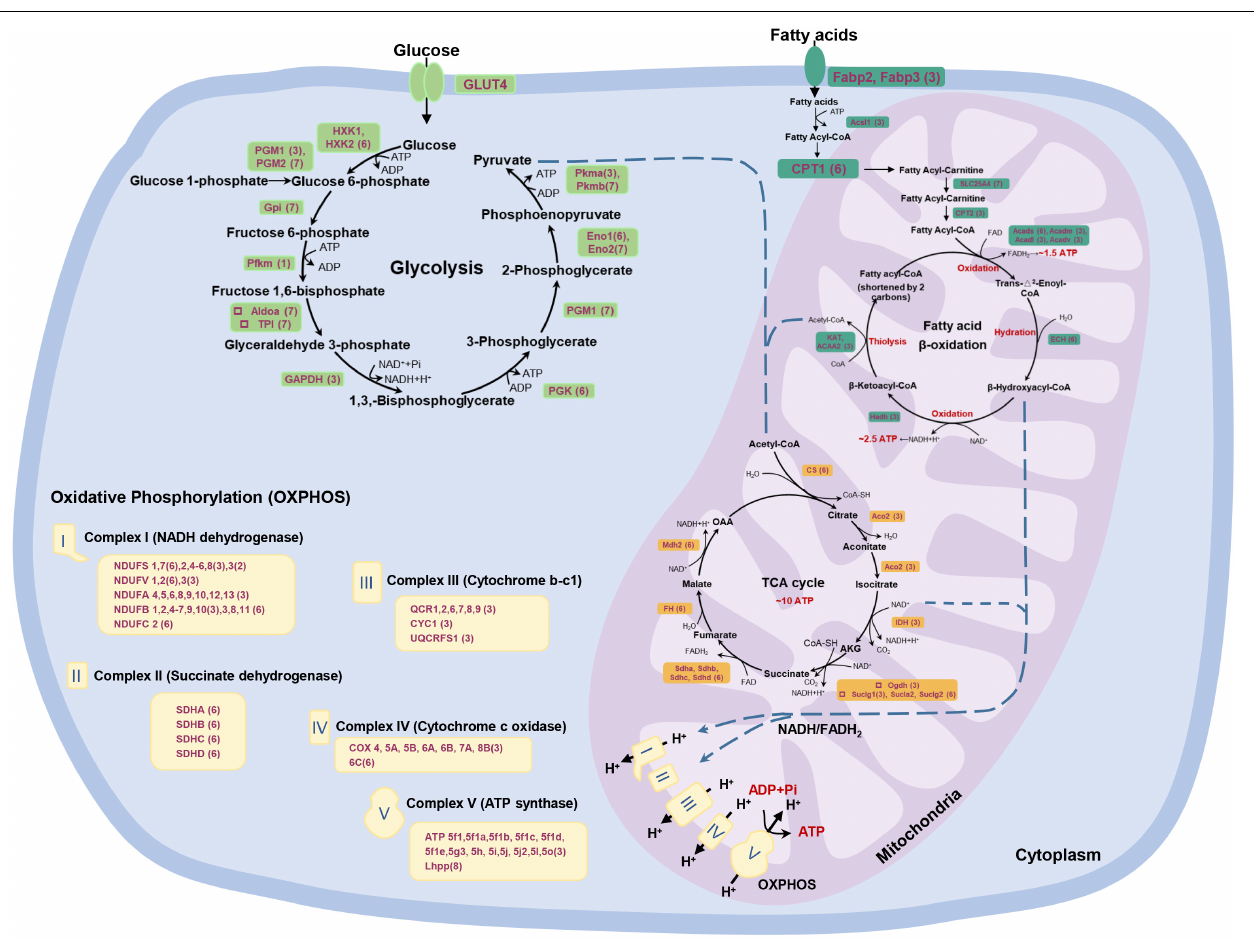
FIGURE 7 | A global view of P. dentex skeletal muscle metabolism from the point of integrative proteome and transcriptome. The metabolic network includes glycolysis, fatty acid β -oxidation, tricarboxylic acid (TCA) cycle, and oxidative phosphorylation, all constructed by the Kyoto Encyclopedia of Genes and Genomes (KEGG) pathway. The expression information of each gene in P. dentex skeletal muscle is shown in parentheses, corresponding to the quadrant distribution in Figure 5C